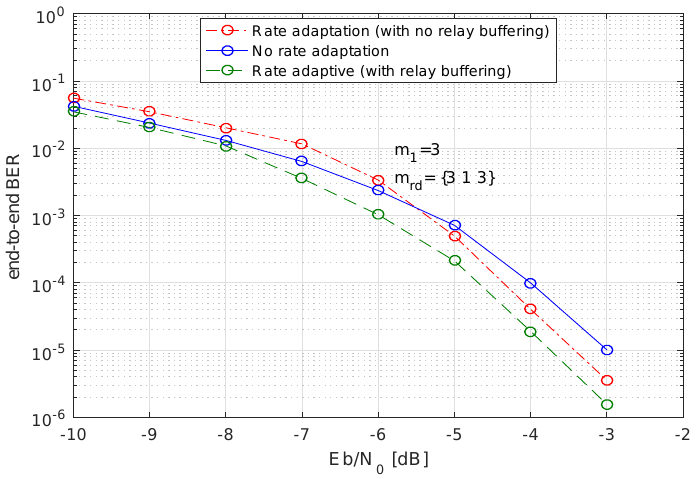
Figure 7. BER of multiple relays (three relays) with an equal transmit power (decreased by a factor of 2), codeword length n = 648, C R at source 1/2, and